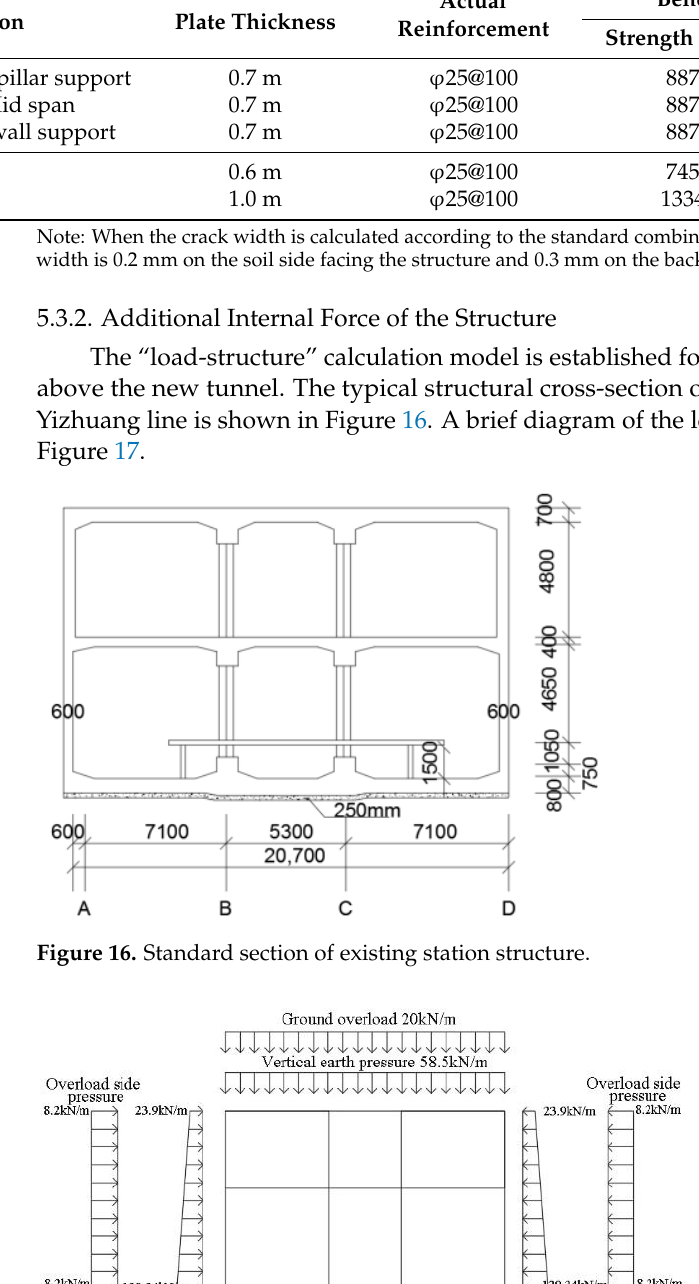
Figure 17. Load calculation diagram.